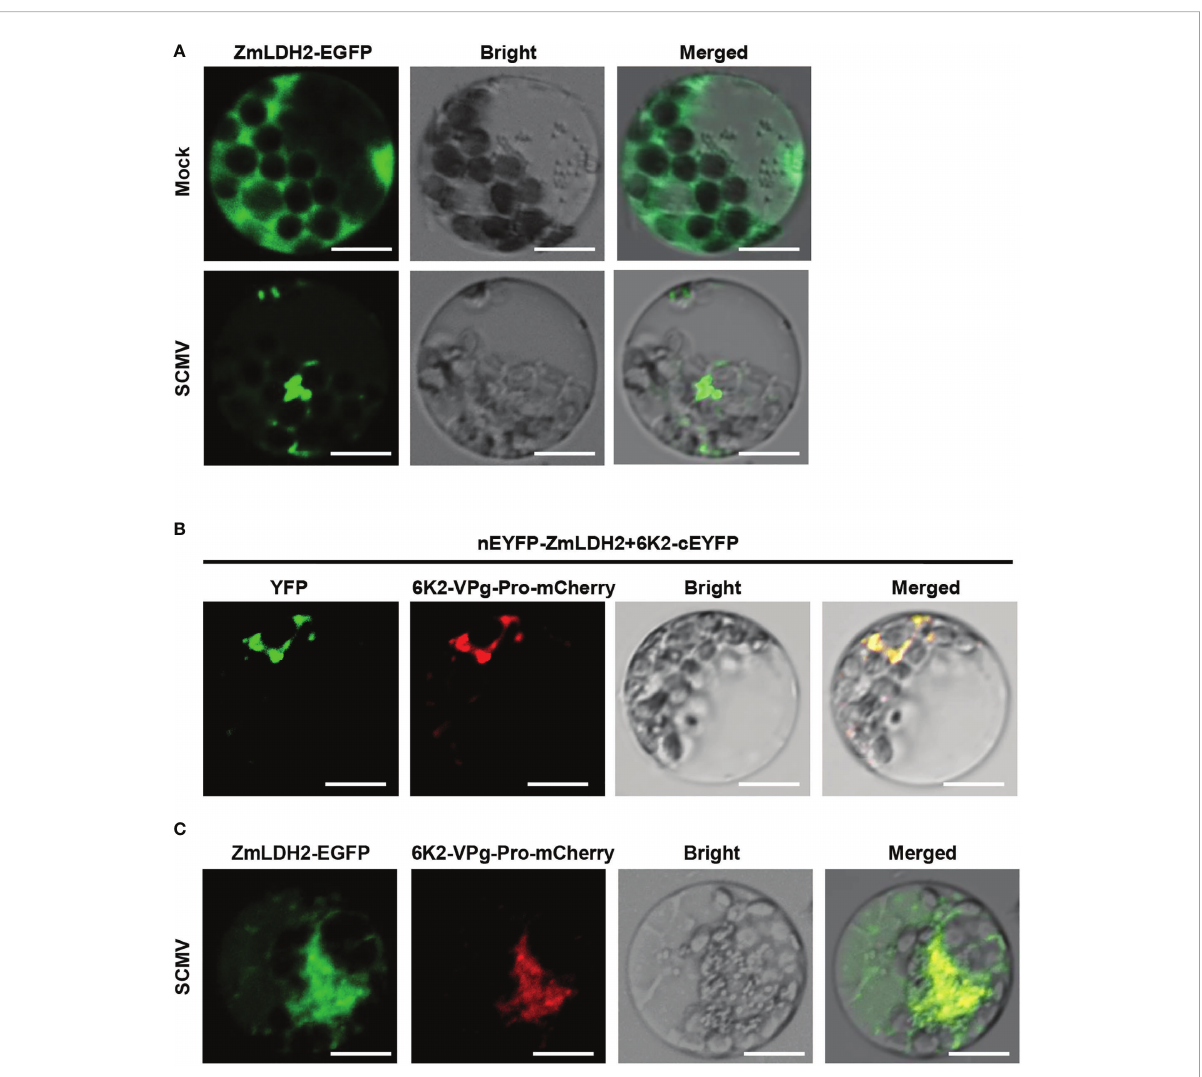
FIGURE 6 Subcellular colocalization of ZmLDH2 with SCMV viral replicase complexes (VRCs) in maize protoplasts. (A) Subcellular localization of ZmLDH2- GFP in mock-transfected or SCMV-infected maize protoplasts. Images were taken at 14 h post transfection. Scale bars = 20 µm. (B) Co- localization assay of BiFC signals with the SCMV VRCs marker 6K2-VPg-Pro-mCherry in maize protoplasts. Images were taken at 14 h post transfection. Scale bars = 20 µm. (C) Co-localization of ZmLDH2-GFP with the SCMV VRCs marker 6K2-VPg-Pro-mCherry in SCMV-infected maize protoplasts. Images were taken at 14 h post transfection. Scale bars = 20